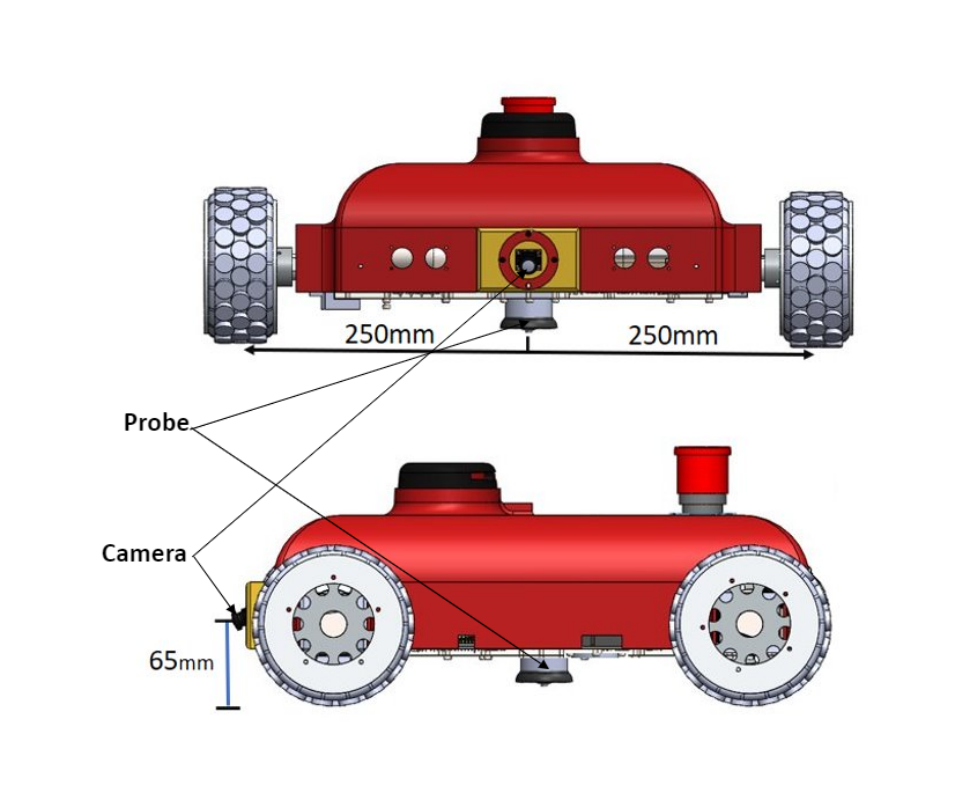
Figure 6. Camera and probe